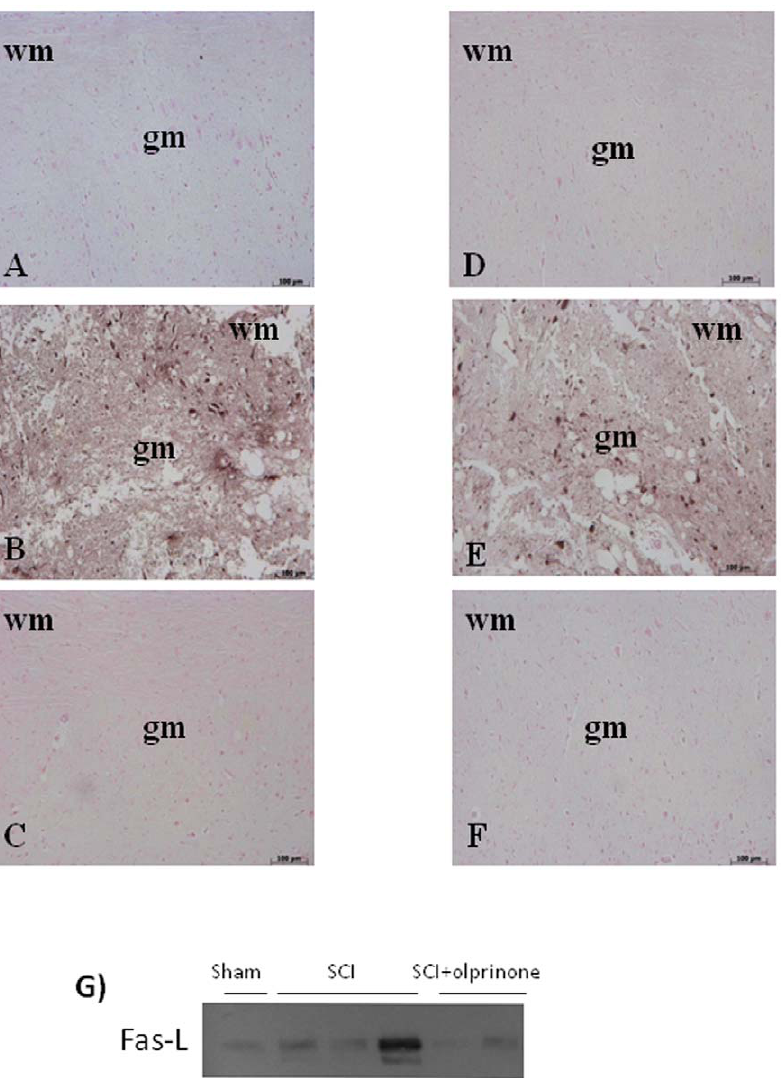
Figure 8. Effect of olprinone on immunohistochemical localization and expression of Fas-ligand. At 24 hr after SCI a substantial increase in Fas-ligand expression ( B ) was found in inflammatory cells, in nuclei of Schwann cells in wm and gm of the spinal cord tissues. Spinal cord Fas- ligand was significantly attenuated in olprinone-SCI treated mice in comparison to SCI animals ( C ). Moreover, SCI increased the number of S100 b immunoreactive astrocytes in the white and grey matters of the spinal cord at caudal levels adjacent to the injury ( E ). This number of S100 b immunoreactive astrocytes is significantly reduced in the spinal cord obtained from oprinone-treated SCI mice ( F ). Densitometry analysis of immunocytochemistry photographs (n=5 photos from each sample collected from all mice in each experimental group) for Fas-ligand and S100 b from spinal cord tissues was assessed. Similarly, at 24 h after SCI, the expression of Fas-ligand in the spinal cord homogenates was investigated by Western blot. A significant increased Fas-ligand ( H ) expression was observed in the spinal cord from mice subjected to SCI. On the contrary, olprinone treatment prevented the SCI-induced Fas-ligand ( H ) expression. This figure is representative of at least 3 experiments performed on different experimental days. wm: White matter; gm: gray